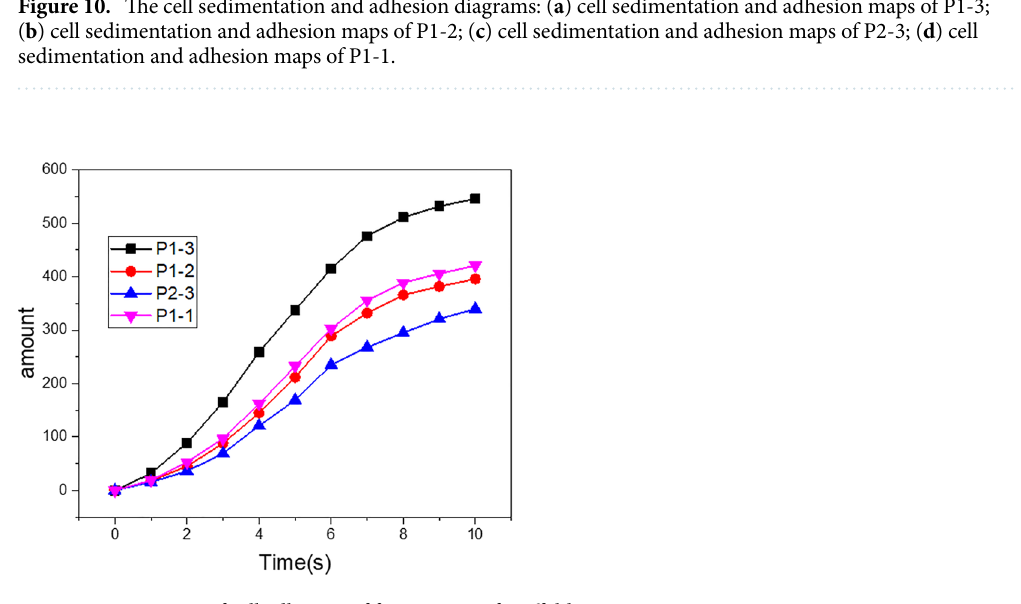
Figure 11. Statistics of cell adhesion of four groups of